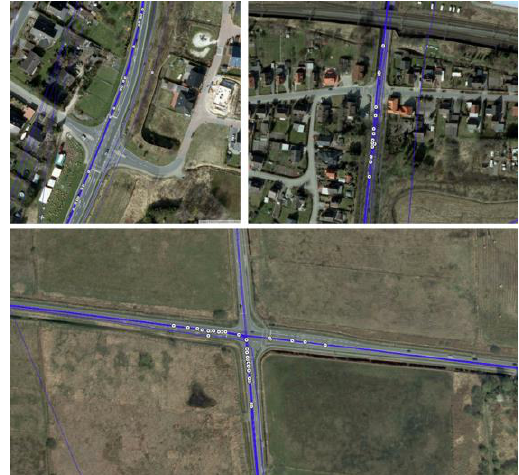
Figure 3. Stop events (white spheres) at controlled